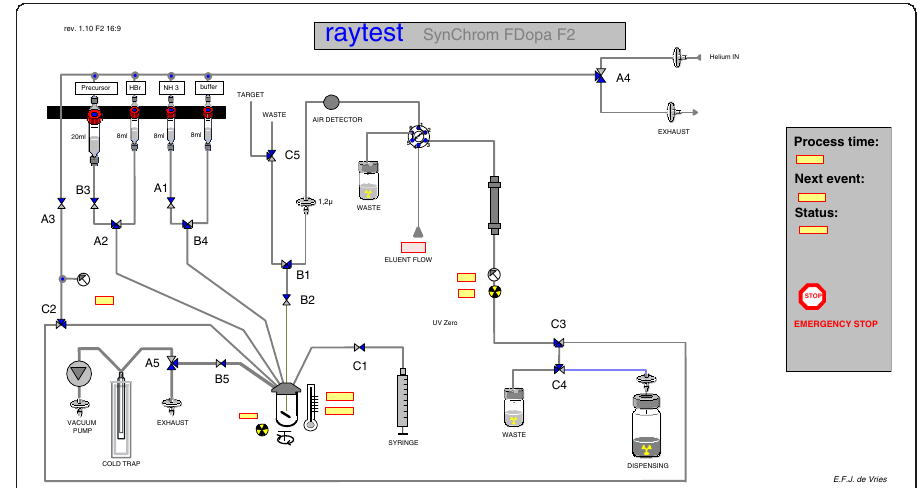
Fig. 1 A schematic overview of FDOPA synthesis module including HPLC purification, collection of the end product and filter integrity test